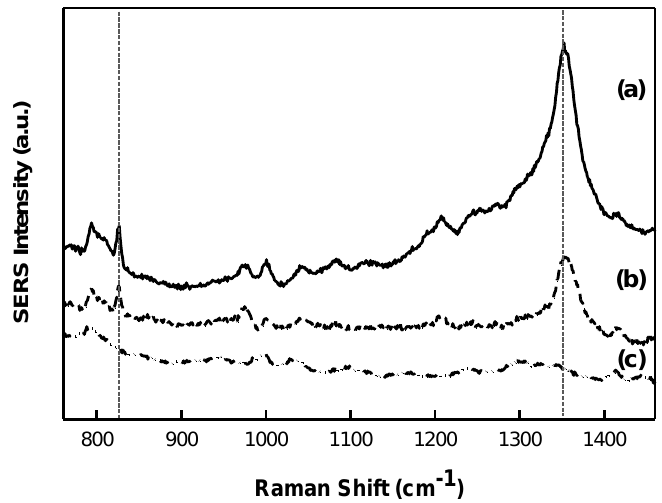
Figure 7. SERS spectra recorded for (a) MIP, (b) control A, and (c) control B after incubation in a 4.0 × 10 −4 M solution of TNT. Spectra are offset for clarity. The vertical dashed lines indicate the peaks related to TNT, which increased after